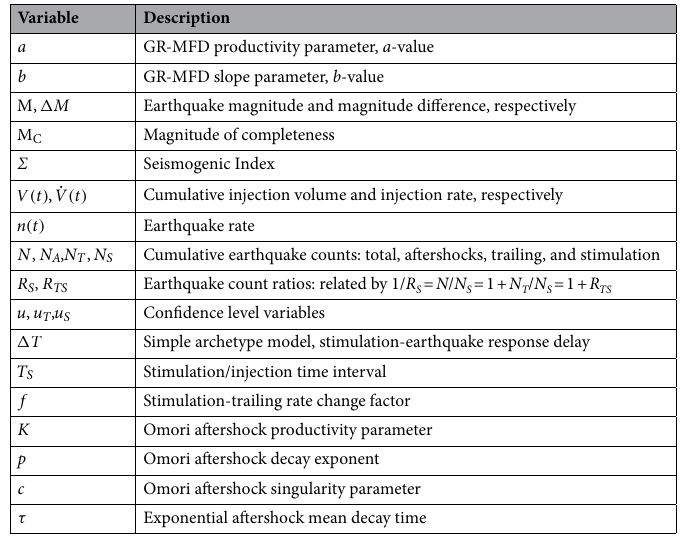
Table 2. Summary of equation parameters and variables. Here we list the relevant parameters used in equations throughout our study, for convenience to the